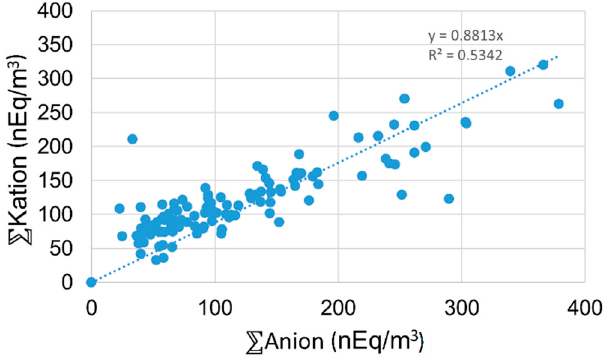
Figure 2. Correlation of the equivalent concentration of cations with the equivalent concentration of anions.